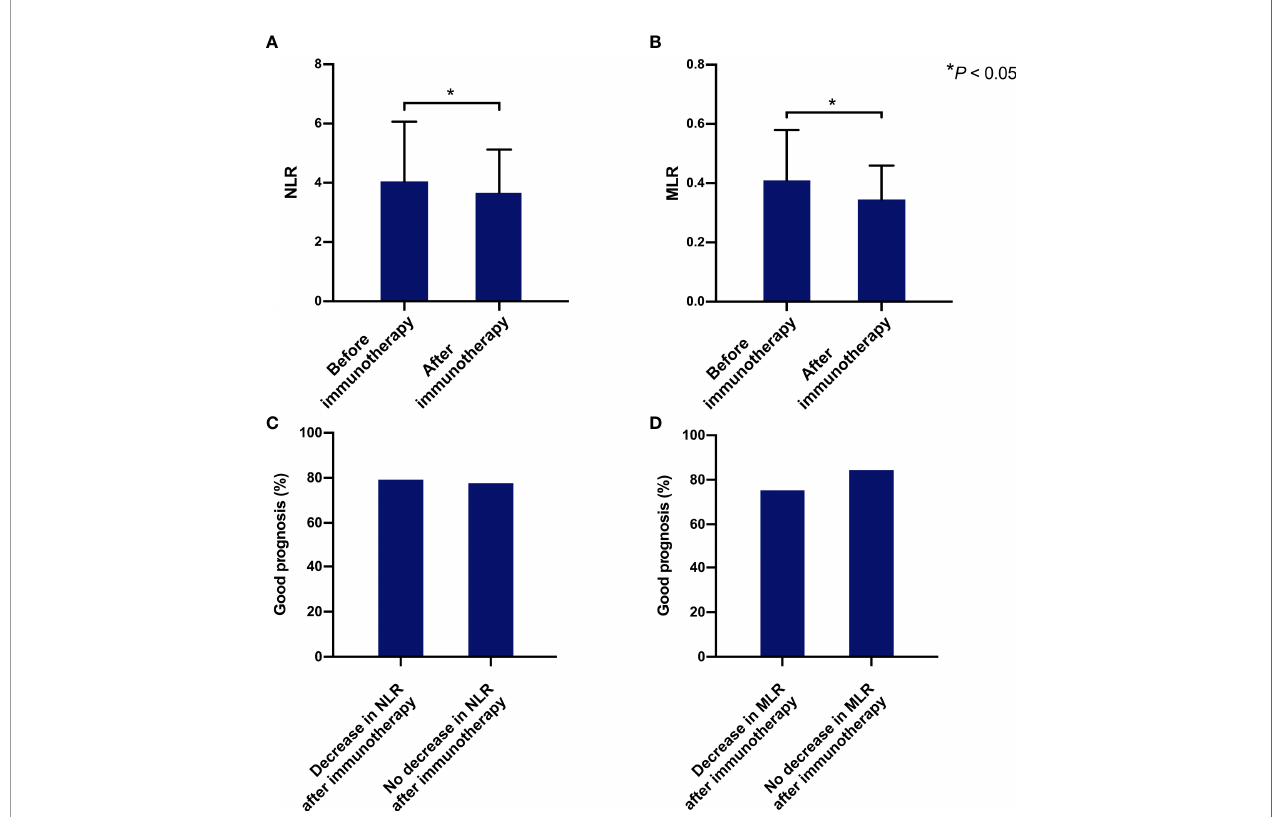
FIGURE 5 | The relationship between the changes of NLR and MLR before and after immunotherapy and the prognosis of patients. The NLR and MLR before and after immunotherapy (A, B) ; Relationship between whether NLR and MLR decrease before and after immunotherapy and patient prognosis (C, D) . * Indicates P